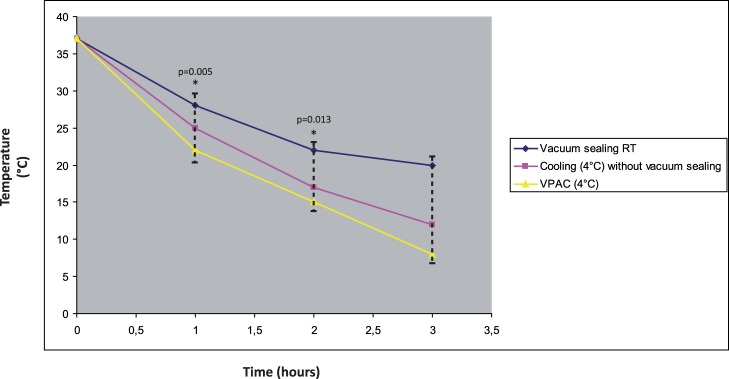
Effect of vacuum and cooling on specimen temperature.Results of temperature monitoring over time of a specimen of reduction mammoplasty. The specimen was subdivided in three parts that were stored under three distinct conditions, i.e. vacuum sealed at room temperature (RT), vacuum sealed at 4°C, cooled at 4°C without vacuum sealing. VPAC produced a more rapid decrease of temperature than non-VPAC procedures, while vacuum sealing at room temperature did not significantly affect temperature decrease. The * indicates statistically significant differences (p = 0.005 at 1 hour, p = 0.013 at 2 hours).